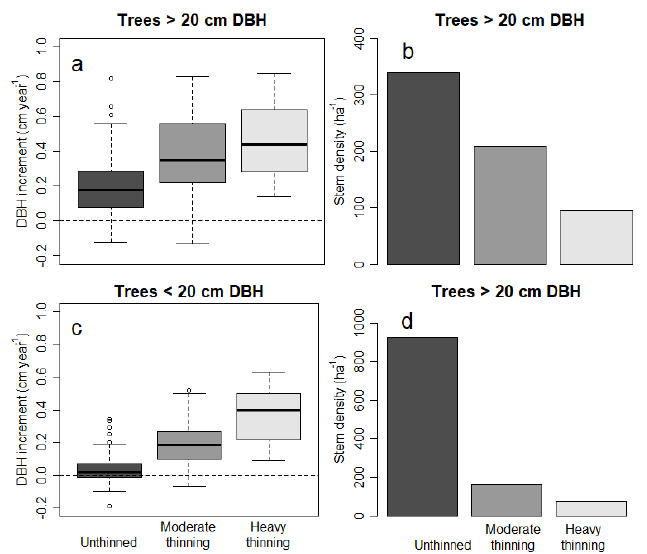
Figure 4. Diameter increment of trees measured at both 2009 and 2019 separated into two DBH classes ( a , c ) and their stem density ( b , d ). We separated large trees and small trees using 20 cm DBH as the cut ‐ off. The boxes in ( a ) and ( c ) represent the median and the 25th and 75th percentile, and the whiskers extend to 1.5 of the interquartile range. Observations outside the interquartile range are shown as dots.